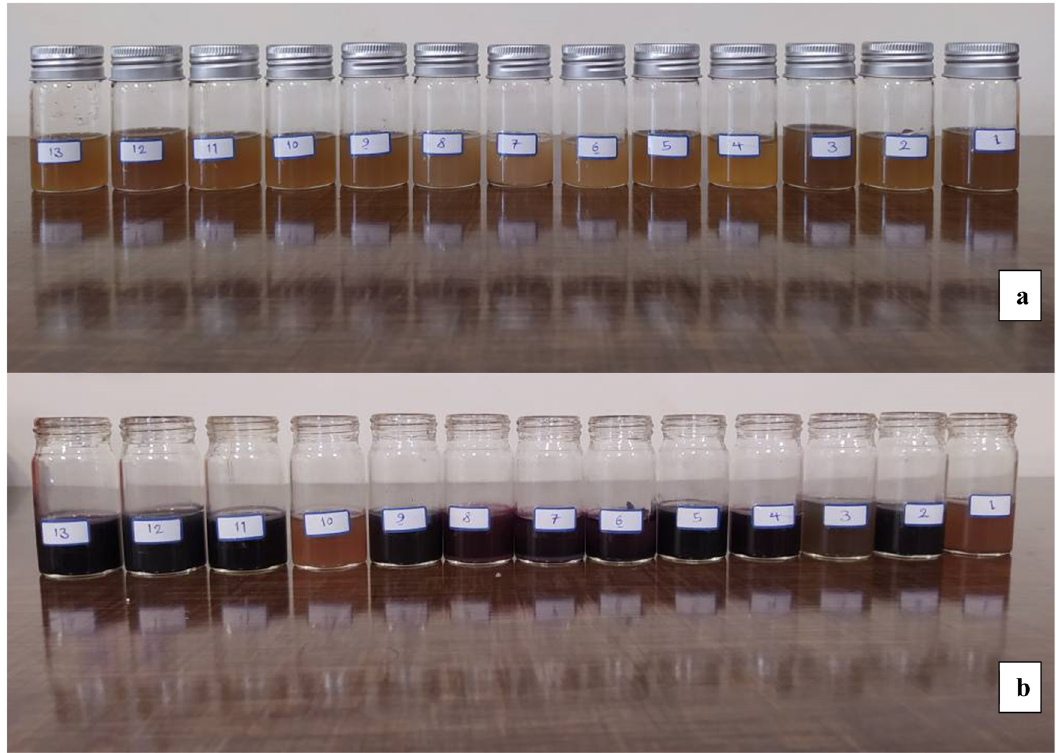
Figure 7: Appearance and color of the mixture solution before ( a ) and after ( b ) formation of the Au NPs via UV